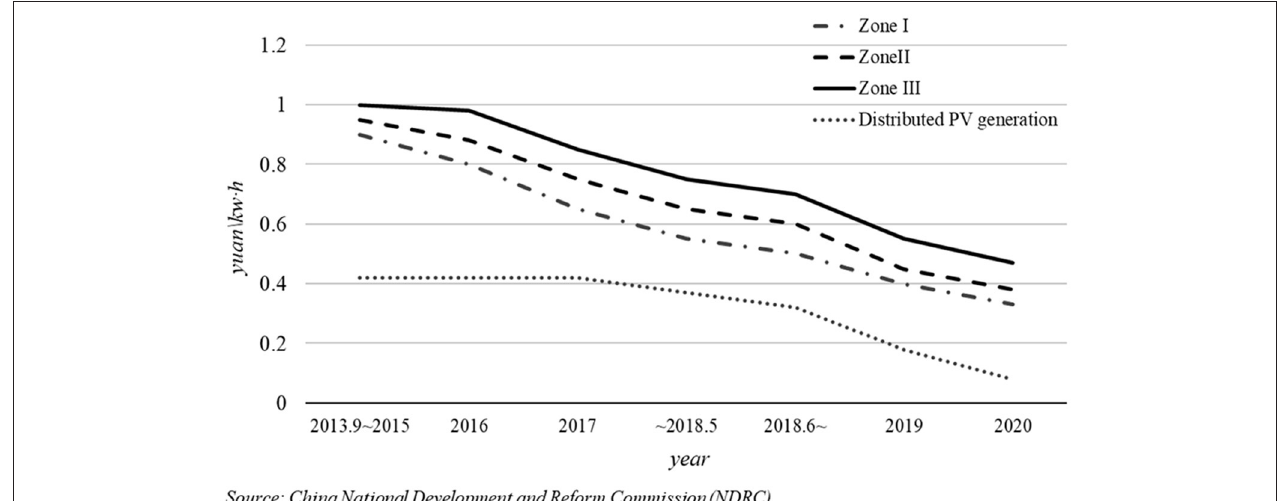
FIGURE 2 | Overview of photovoltaic subsidy (FIT) adjustment of